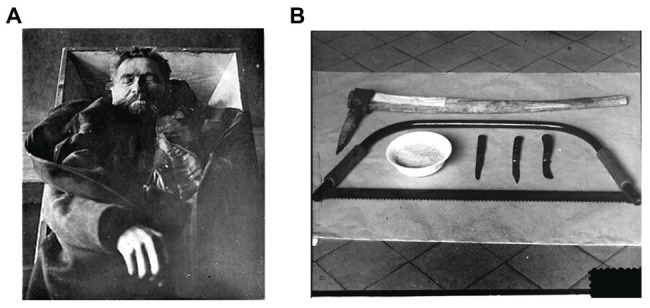
Profile and weapons of choice of cannibal K.D. (A) Headshot of K.D. in his grave (1924). This photo has originally been released by the police and is now available in the public domain. (B) Tools discovered in K.D.’s home, presumably used for his murders and later dismemberment of the bodies. Photo from the Medical Academy of Wrocław, presumably originally from the German Institute of Forensic Medicine in Breslau, is now available in the public domain.